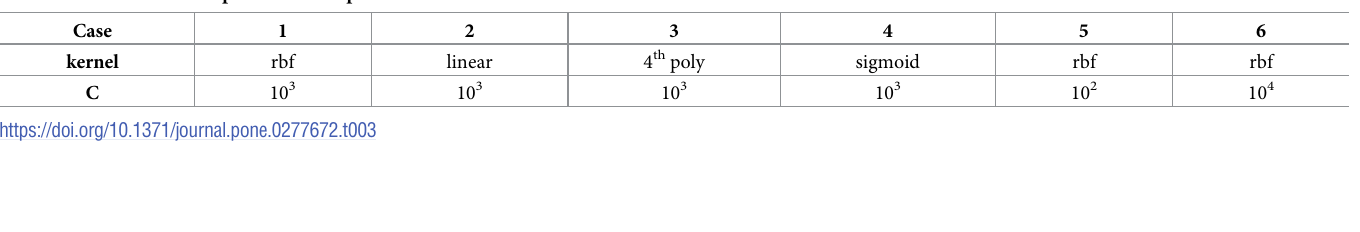
the splitting will be stopped. The criterion is chosen to be ‘squared_error’. The minimum